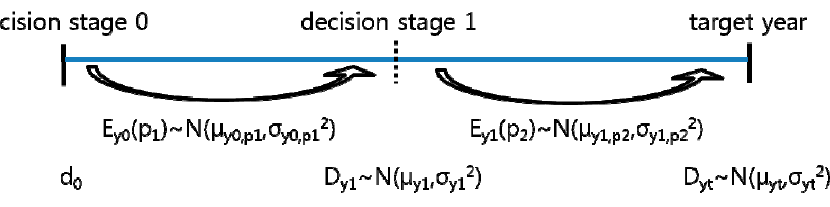
Figure 3. Demand uncertainty in multi-stage model.